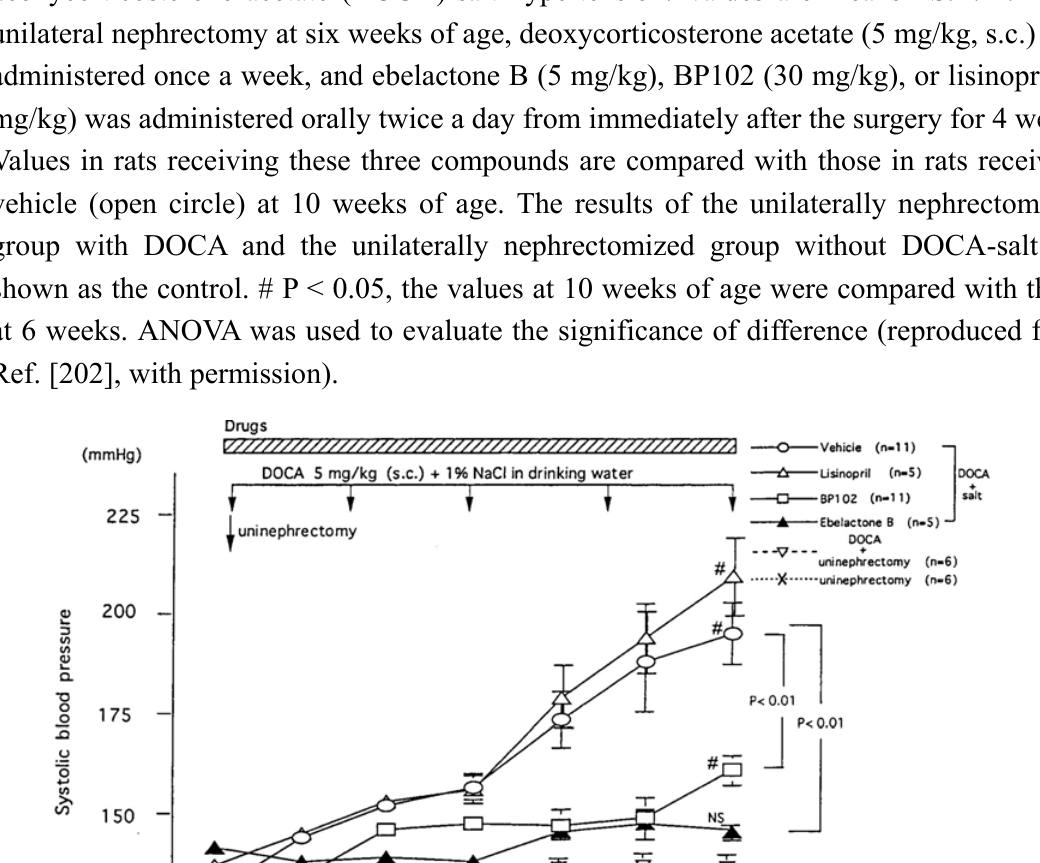
Figure 8 . Effects of ebelactone B, BP102, and lisinopril on the development